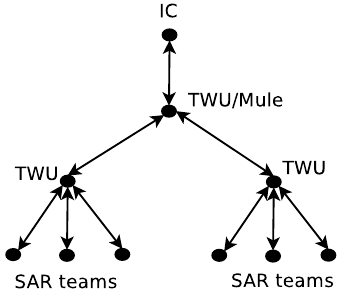
Figure 9. Hierarchical topology of a Flying Real-Time Network (FRTN) that supports first responses after a